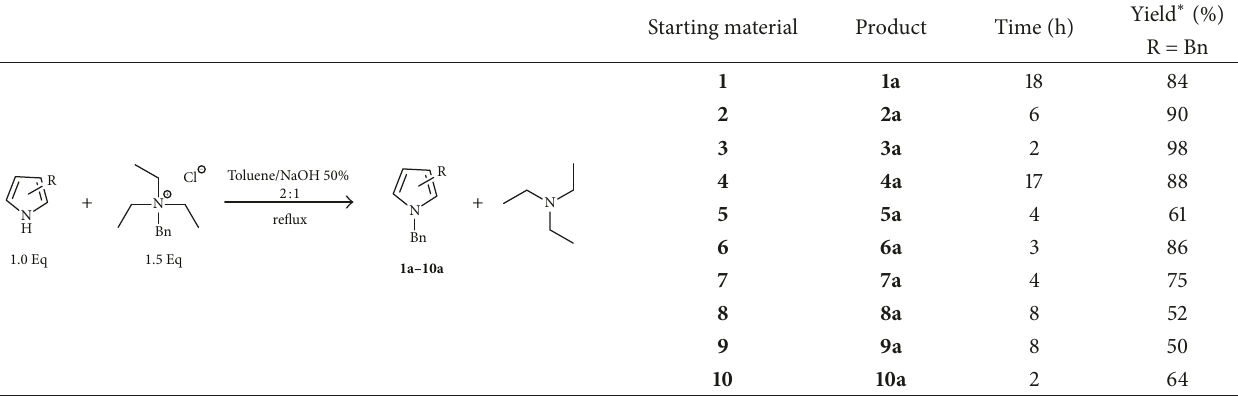
∗ Yields refer to chromatographically pure isolated